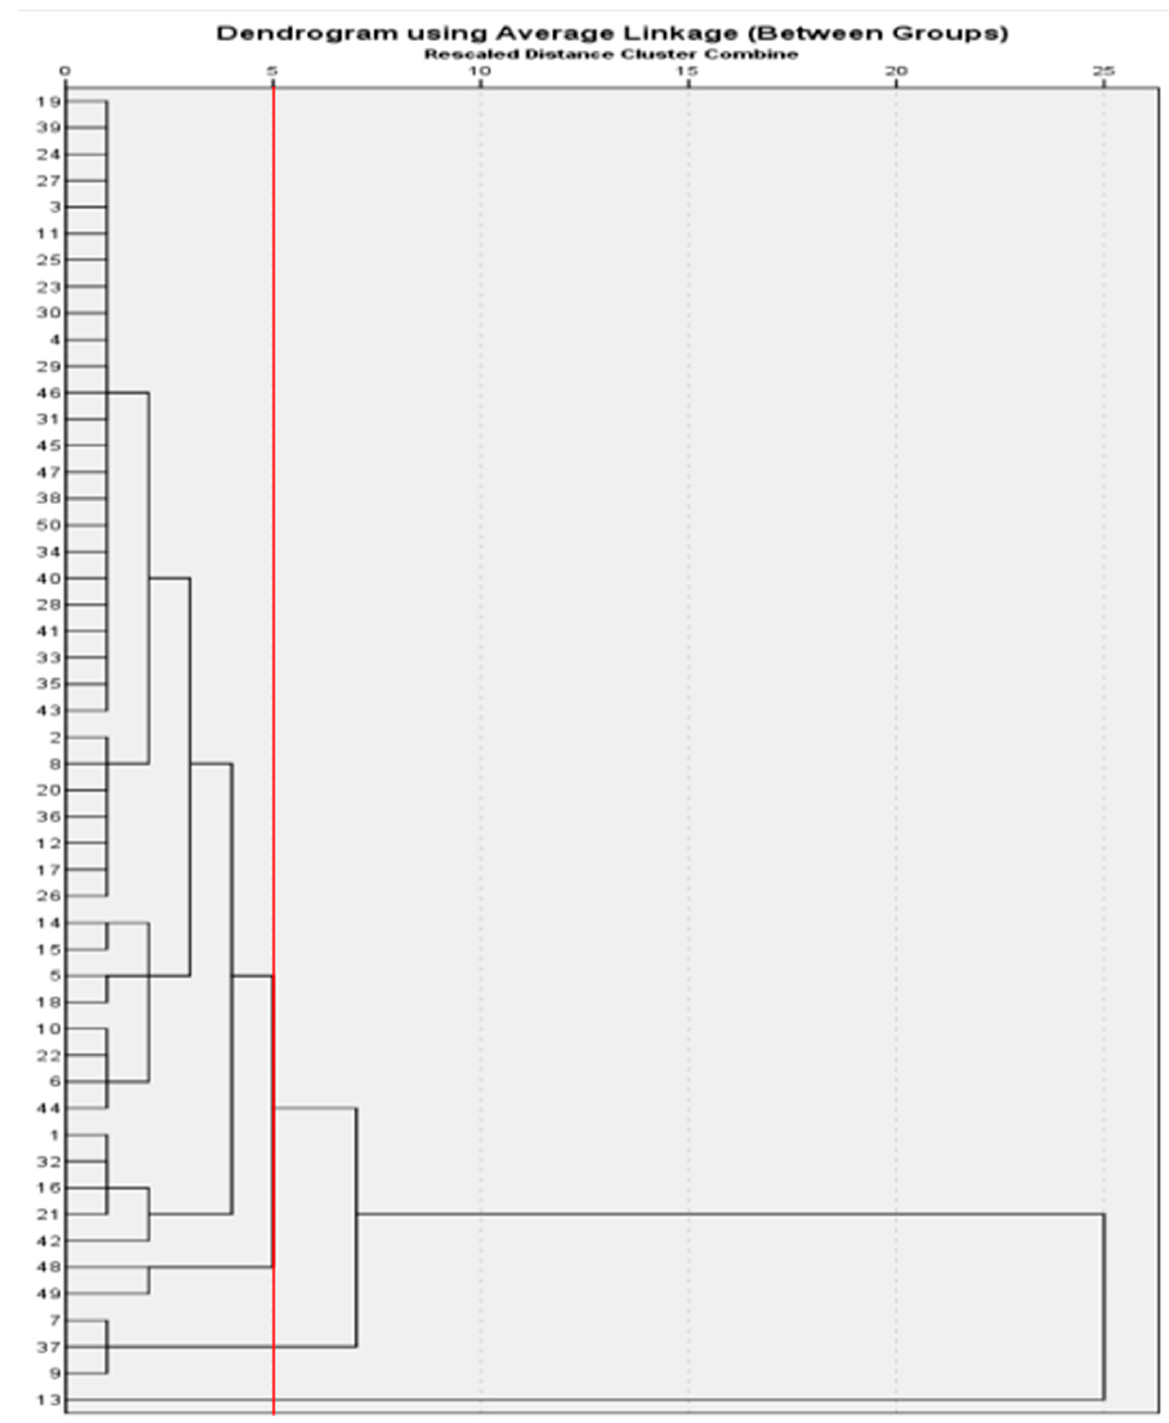
Figure 2. Cluster analysis of the 50 peach germplasms based on the response values recorded by the ten sensors. Note: Red line: cluster rescaled distance cluster d = 5.